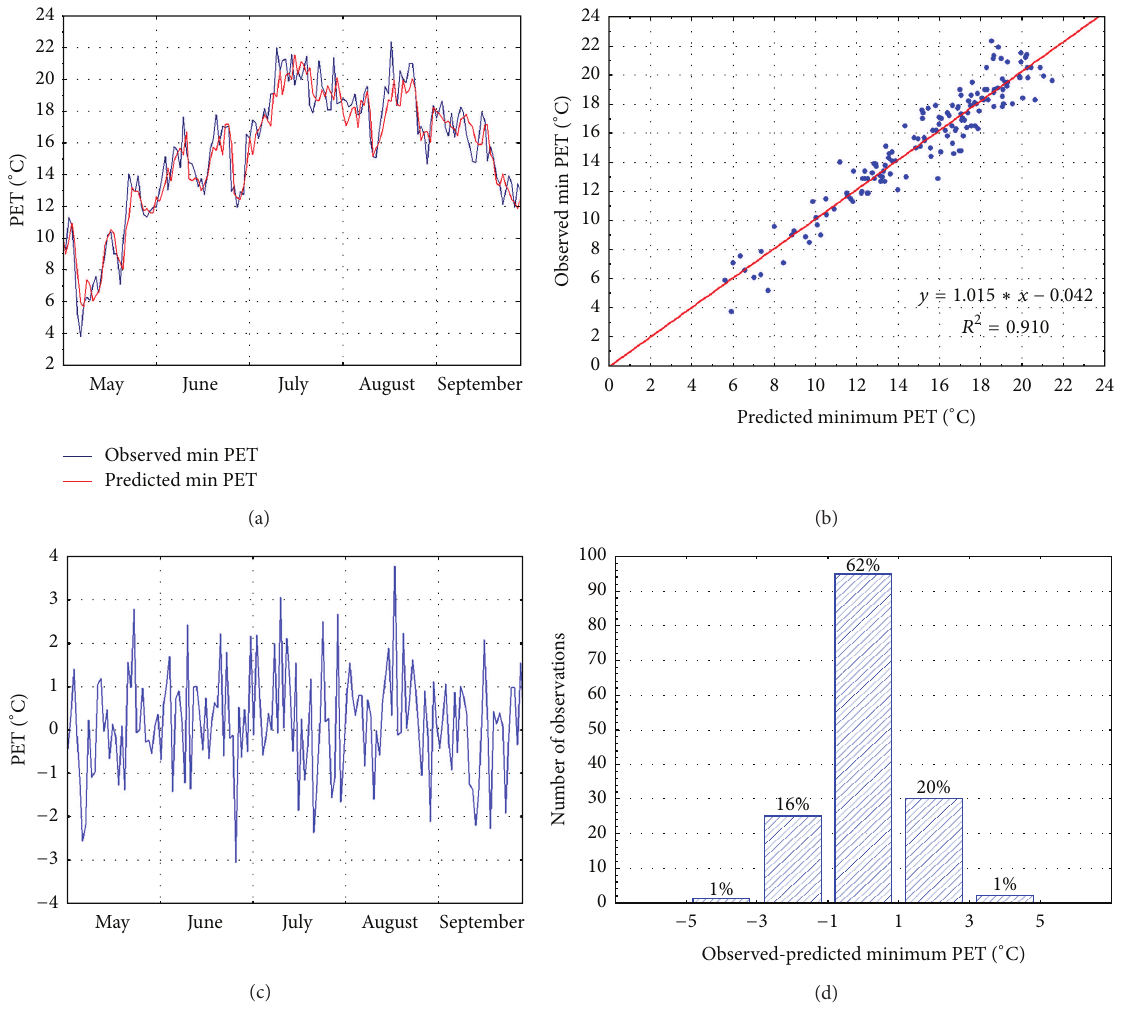
Figure 7: Observed versus predicted daily minimum PET values (a); scatter plot between observed versus predicted daily minimum PET values (b); observed minus predicted minimum daily PET values (c) and histogram with the absolute differences between the observed and the predicted minimum daily PET values (d). One day ahead prognosis. Warm period of 2011.